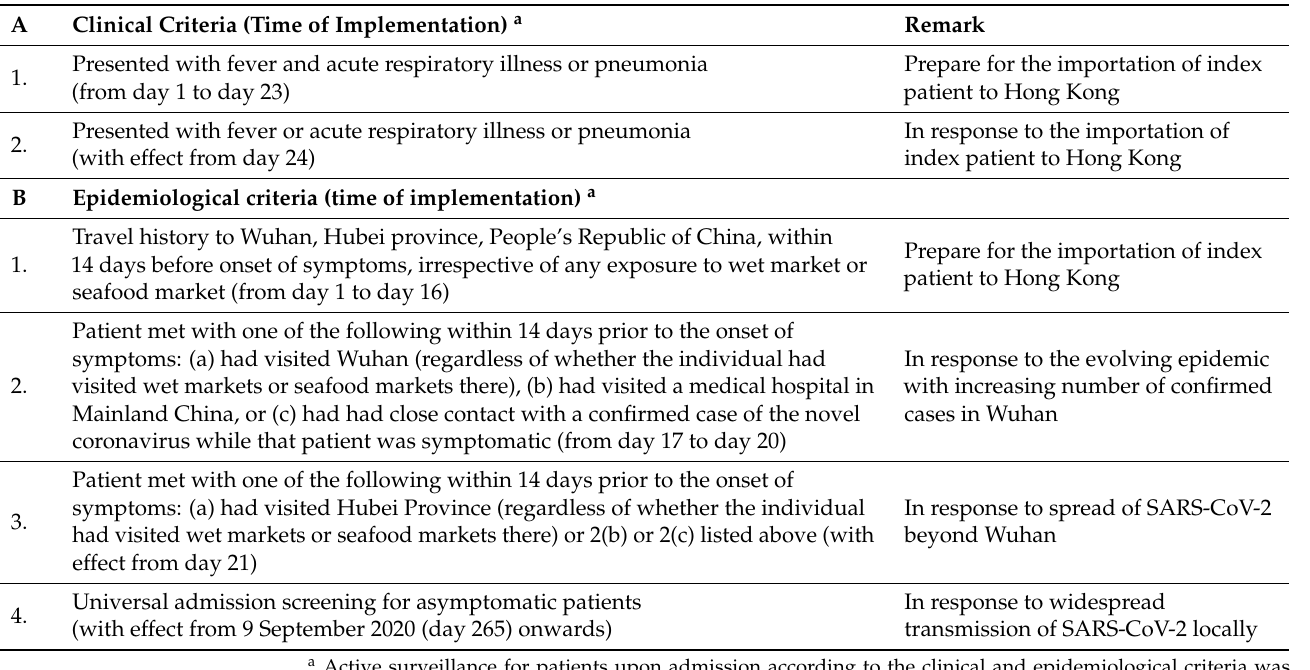
Table 4. Stepwise enhancement of active surveillance for early isolation of COVID-19 patients in airborne infection isolation rooms